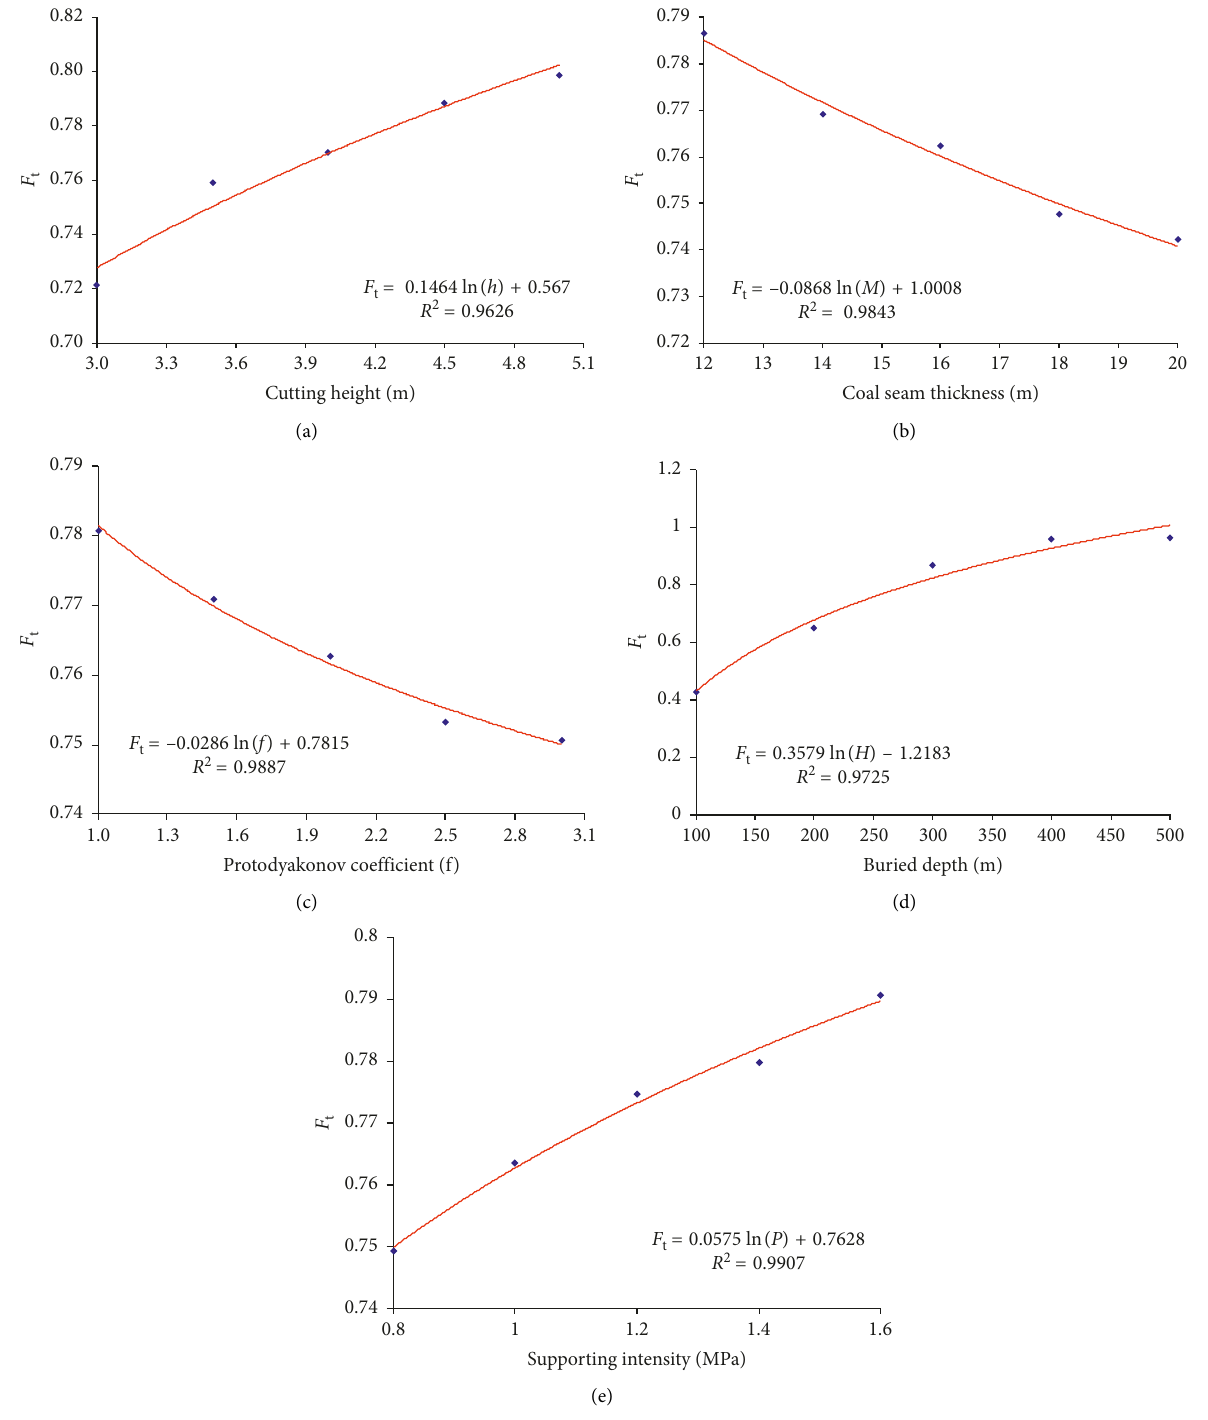
Figure 3: The fitting curves of each factor and F